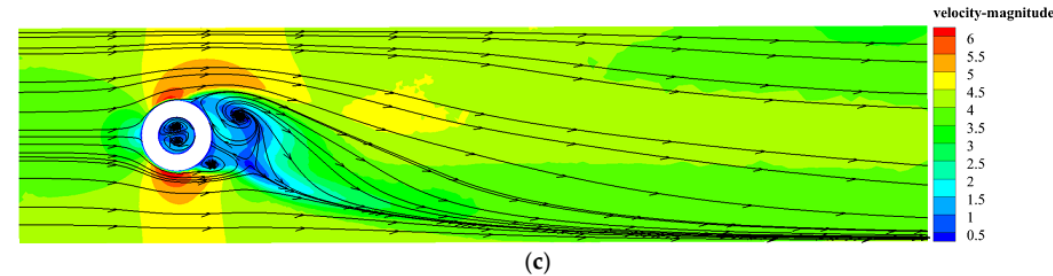
Figure 12. Distribution of velocity and streamlines evolution in xy-plane for different inlet wind velocities: ( a ) 0.1 m/s; ( b ) 1.5 m/s; and ( c ) 4 m/s.